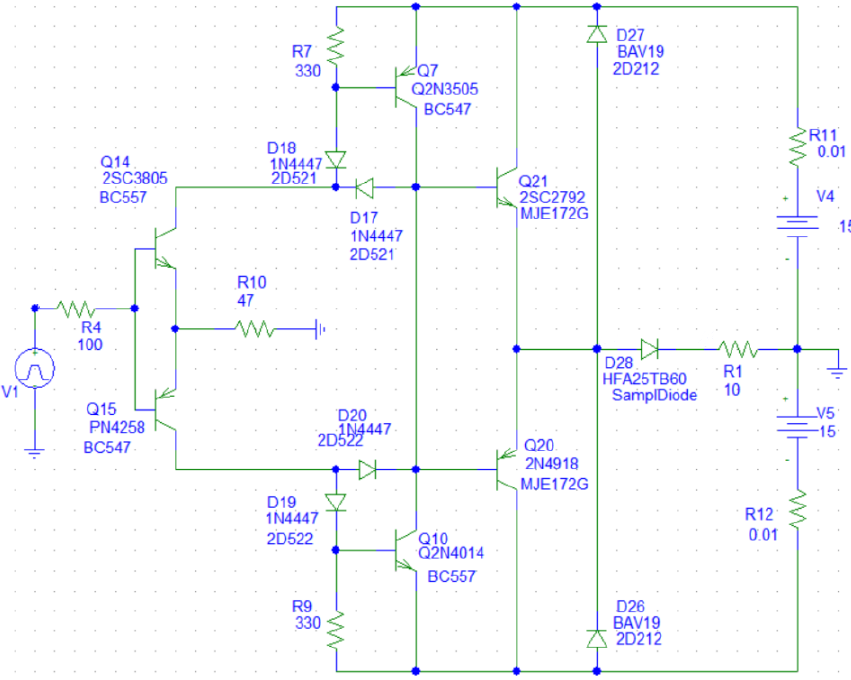
Figure 3. Simulation model of a pulsed amplifier in the OrCad program.